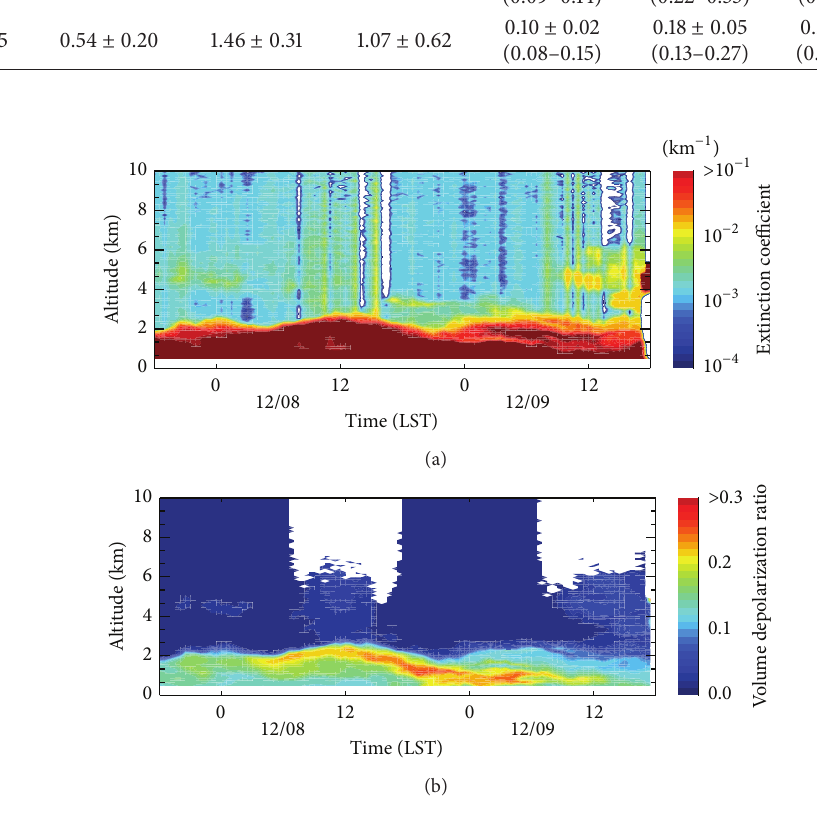
Figure 6: Same as Figure 2, except for the date, 7–9 December